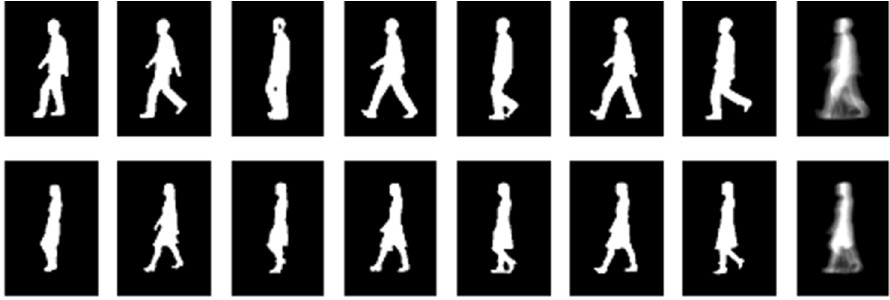
Figure 2. Examples of Gait energy image, last column, computed by using a set of normalized binary sihouette images representing a walking cycle.